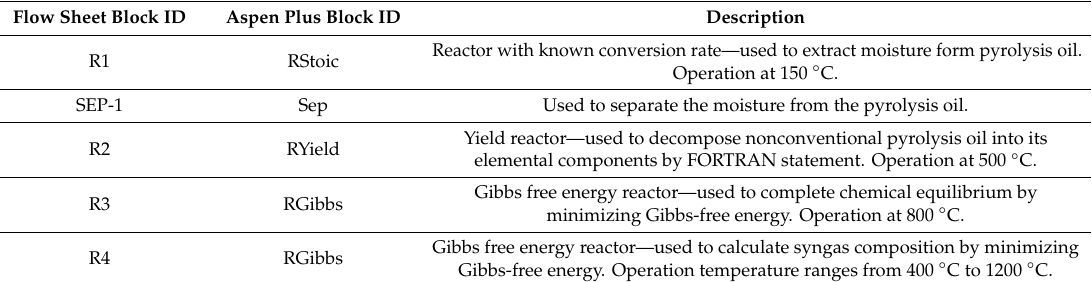
Table 2. Description of Aspen plus blocks used in the gasification